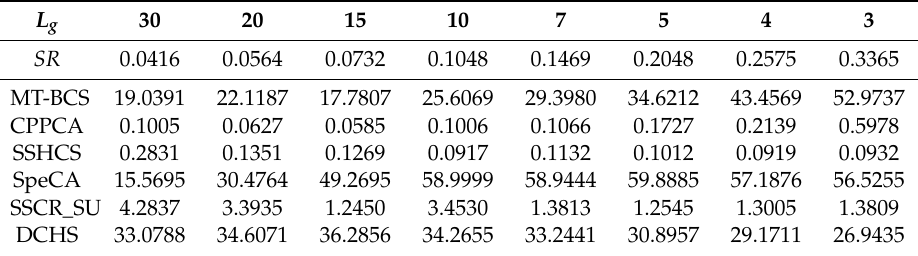
Table 3. Comparison of runtime(s) for the various algorithms on Cuprite